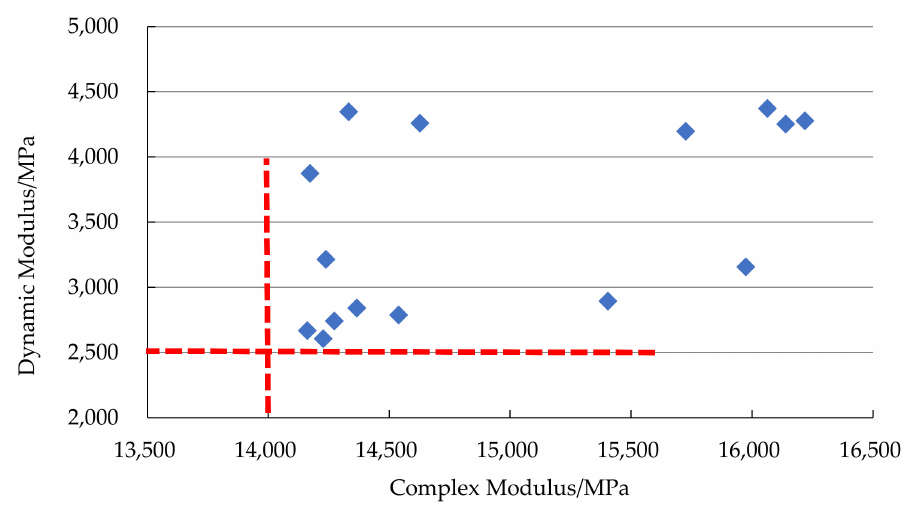
Figure 13. Corresponding relationship of modulus at 45 ◦ C, 10